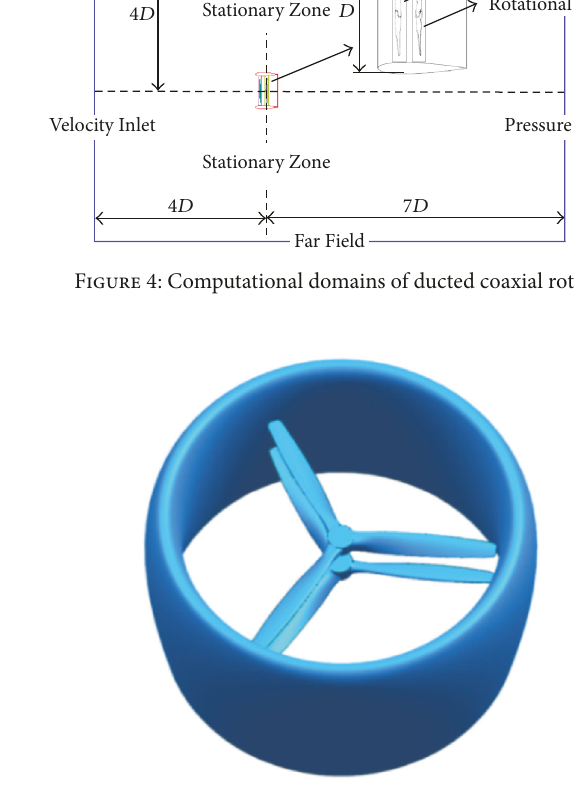
Figure 5: Geometric model of ducted coaxial